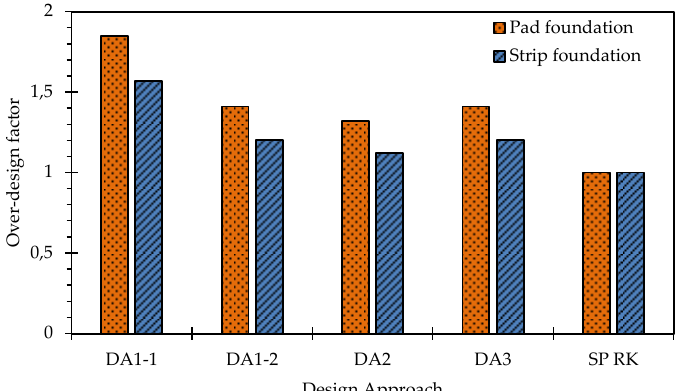
Figure 7. Comparison of the values of over-design factor for pad and strip foundations adhering to Kazakhstani and European approaches.